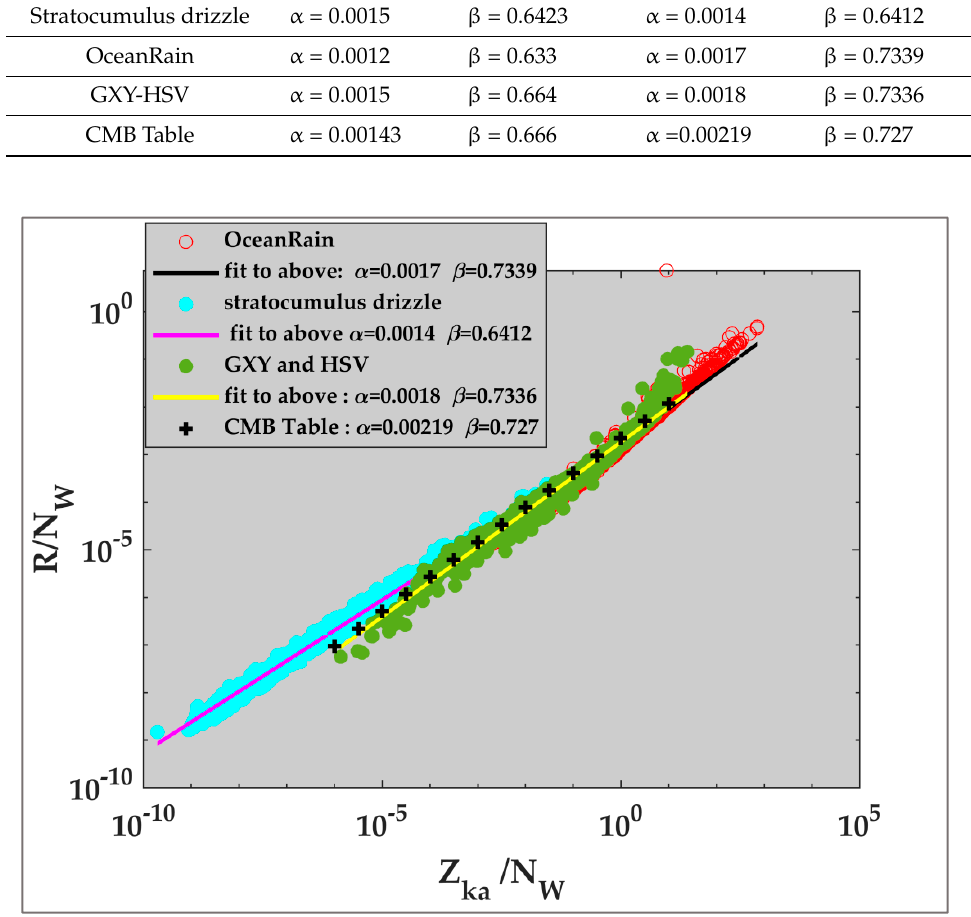
Figure 11. As in Figure 10, but for Ka-band.